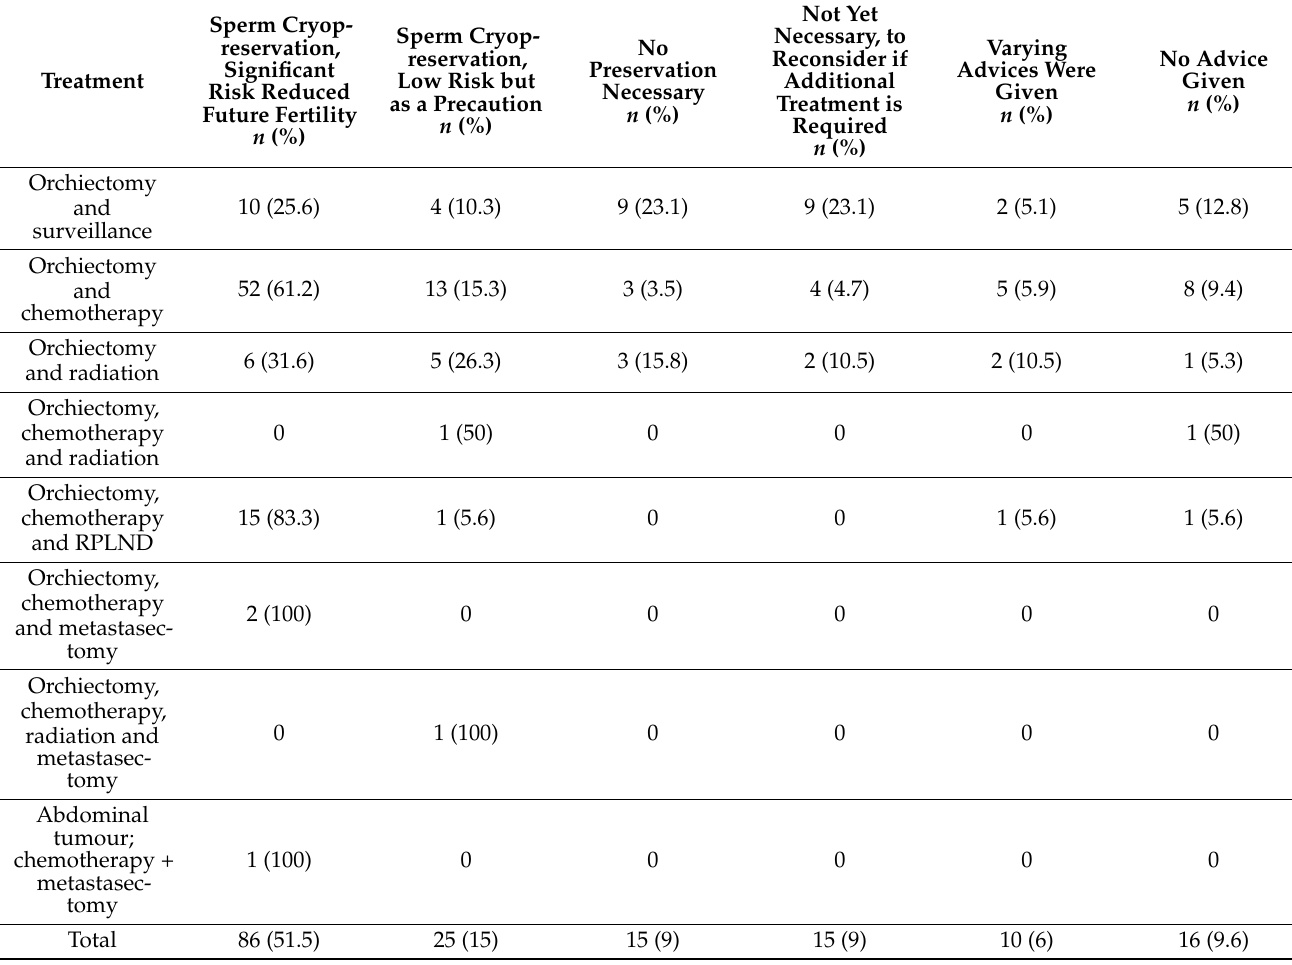
Table 4. Advice from physicians regarding sperm preservation in relation to